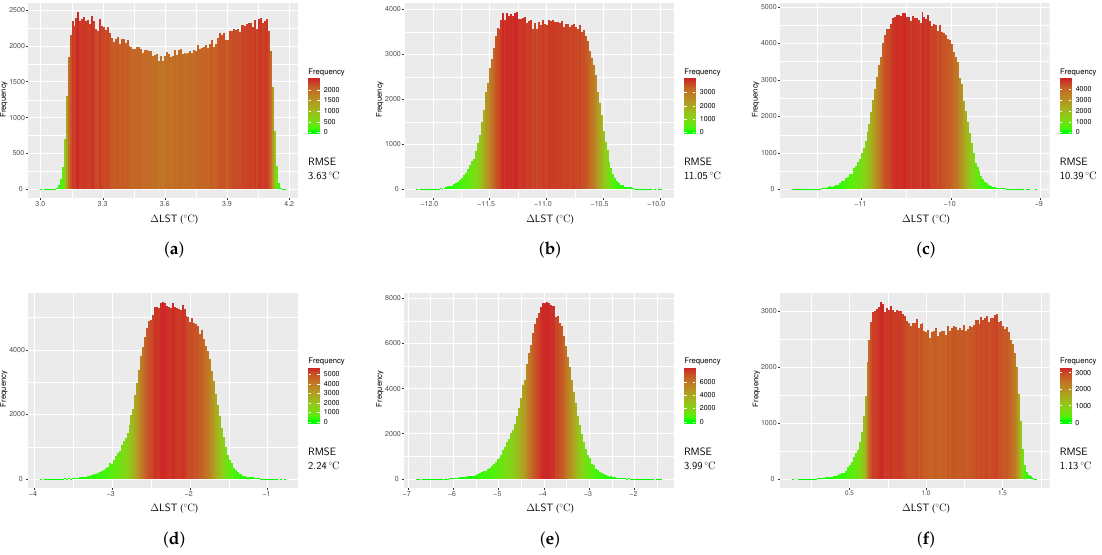
Figure 7. Histograms of temperature difference between the reference LST (LST ref ) and LST from Du et al.’s Split-Window algorithm (LST Du ) for Landsat 8 image of 21 February 2018; ( a ) w = 0.0to 2.5gcm − 2 , ( b ) w = 2.0to 3.5gcm − 2 , ( c ) w = 3.0to 4.5gcm − 2 , ( d ) w = 4.0to 5.5gcm − 2 , ( e ) w = 5.0to 6.3gcm − 2 , and ( f ) w = 0.0to 6.3gcm − 2